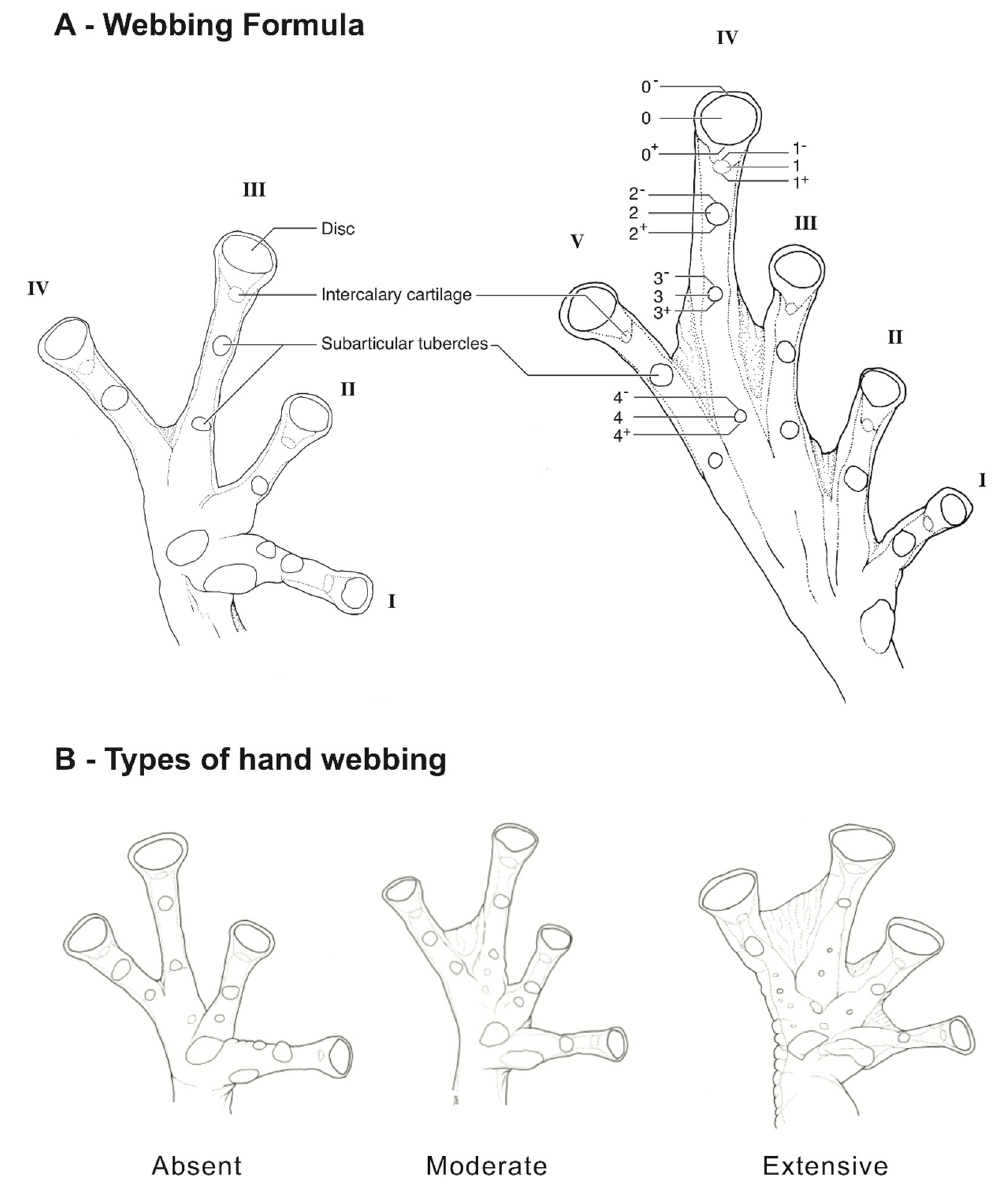
Figure 11. Webbing in glassfrogs. ( A ) Terminology used for webbing formula in hands and feet (see Guayasamin et al. [20]; modified from Savage and Heyer [44]). Roman numerals (I, II, III, IV, V) represent fingers or toes. Arabic numerals represent the number of phalanges completely or partially free of webbing. We use 0 − to indicate that webbing reaches the distal margin of the disc; 0 indicates that webbing reaches the middle of the disc; 0 + indicates that webbing reaches the proximal margin of the disc; 1 − indicates that webbing reaches the distal margin of the intercalary cartilage; 1 indicates that the webbing the middle of the intercalary cartilage; 1 + indicates that the webbing the proximal margin of the intercalary cartilage; 2 − indicates that webbing reaches the distal margin of the distal subarticular tubercle; 2 indicates that webbing reaches the middle of the distal subarticular tubercle; 2 − indicates that webbing reaches the proximal margin of the distal subarticular tubercle. For example, webbing formula in the illustrated foot is absent between Toes I and II (lateral fringes are not considered as webbing); II 1 2 / 3 —3 + III 1 2 / 3 —3 − IV 3 − —2 V . Figure modified from Guayasamin et al. (2006). ( B ) Simplified type of hand webbing. Absent: Nymphargus cochranae , QCAZ 31113. Moderate: Chimerella mariaelenae , QCAZ 22363. Extensive: Centrolene geckoidea , KU 164490. Drawings by Juan M. Guayasamin.